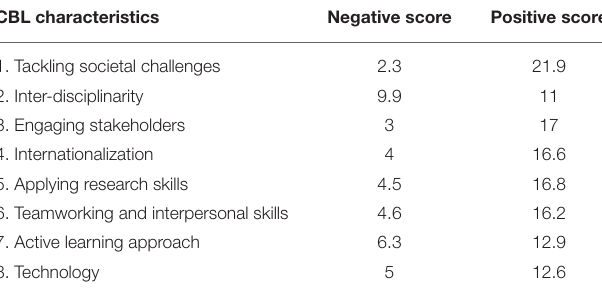
TABLE 2 | Measuring the reception of CBL features in the 2021 Arqus Collaboratory Programme (max = 26). CBL